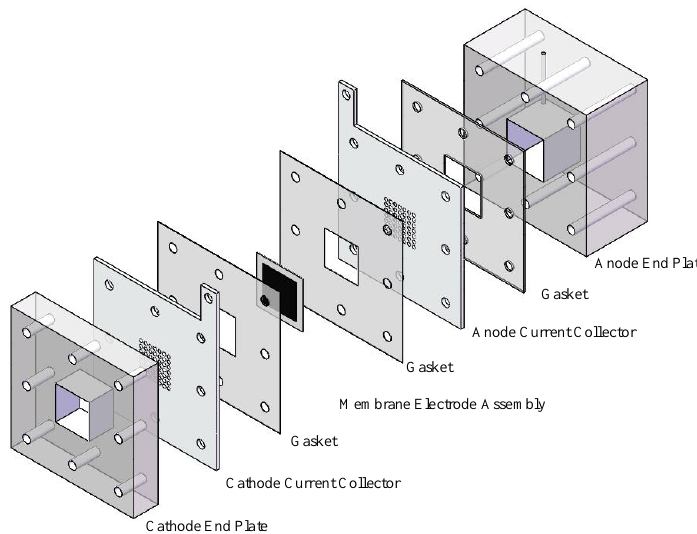
Figure 2. Assembled µ DMFC schematic